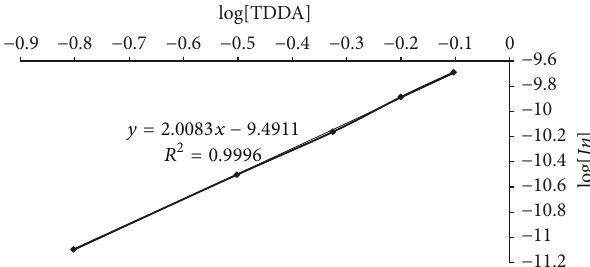
Figure 3: Plot of log [ TDDA ] versus log 𝐽𝜂 (same operating condi- tions as given in Figure